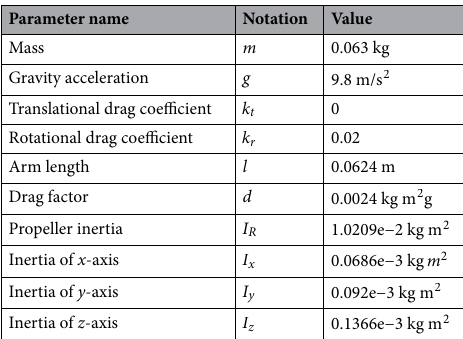
Table 1. The parameters of the